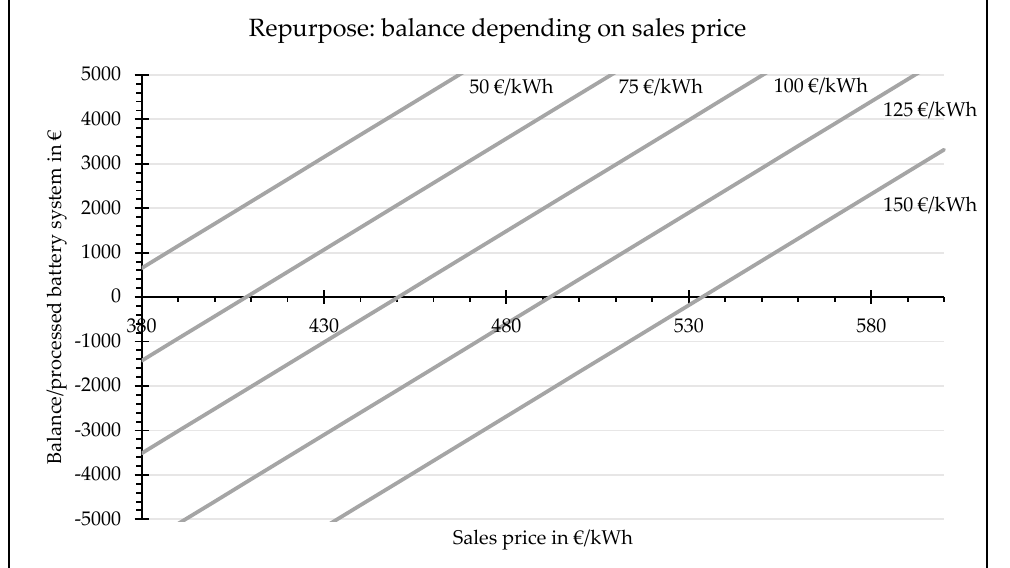
Figure 13. Sensitivity analysis: influence of the sales price in relation to the purchase price on the cost – benefit balance.